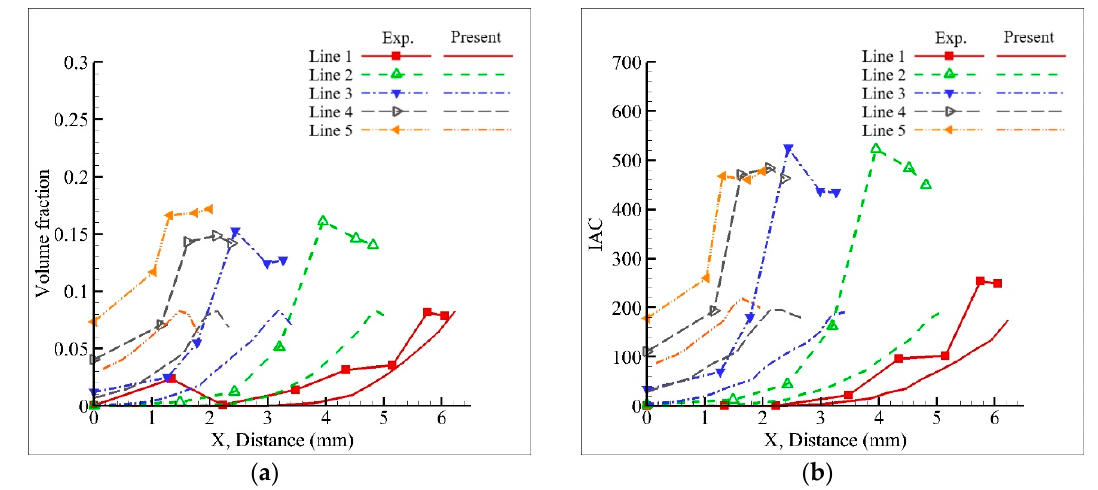
Figure 12. Case 6 numerical results of Lines 1–5 compared with experiment results: ( a ) volume fraction and ( b ) interfacial area concentration.